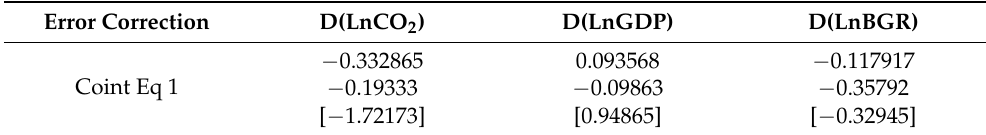
Table 11. VEC model